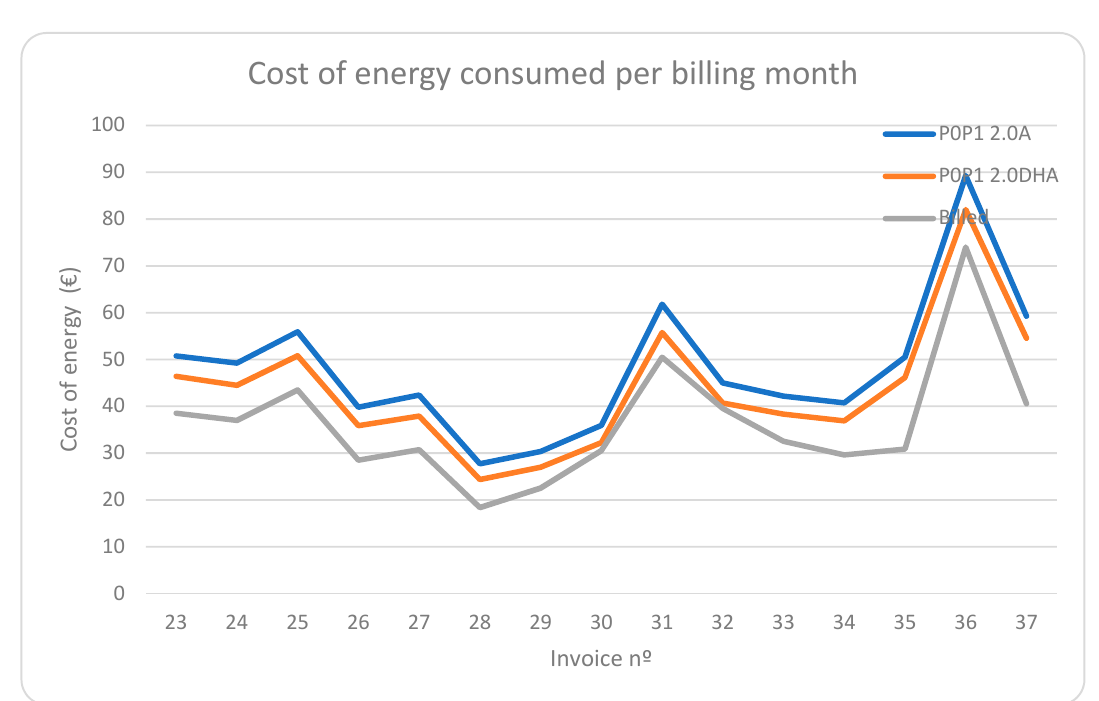
Figure 21. Cost of energy consumed (€) by billing months for the scenario without load shifting or habit adaptation (P0P1 series) and the actual cost billed since implementing the HERMES system.